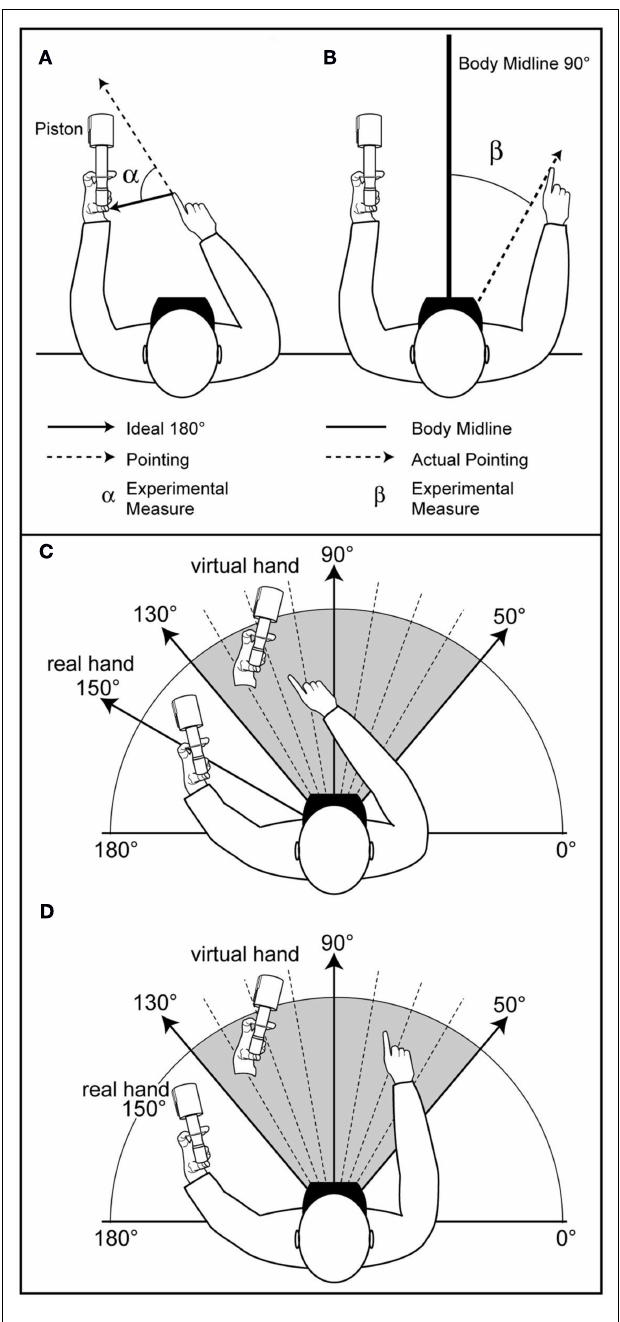
FIGURE 1 | Combined induction of adapted RHi and OBE effects. (A) Measurement ofTTP pointing error. (B) Measurement of SSA pointing error. (C) RHi effect. (D) OBE effect.